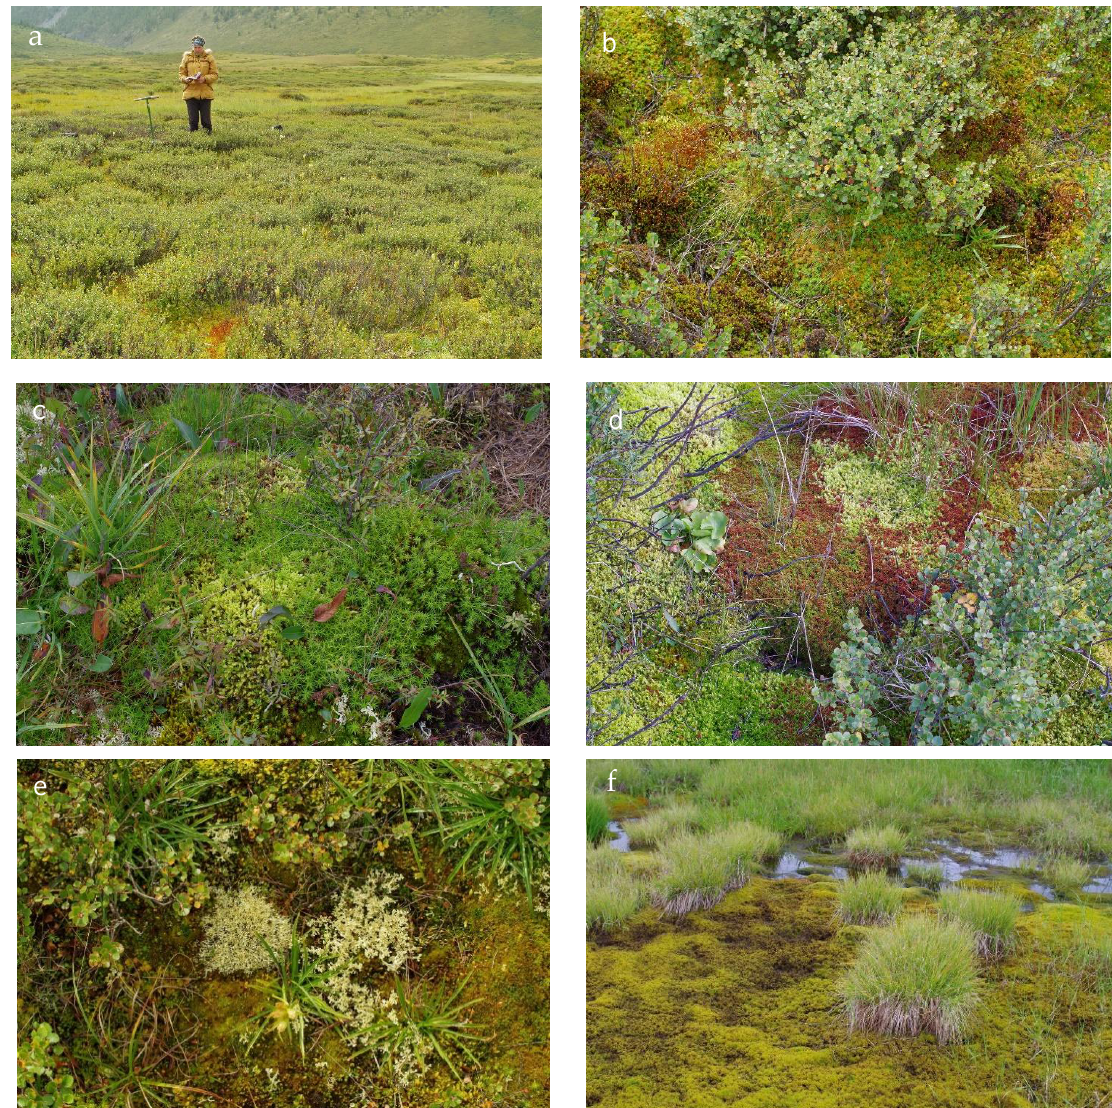
Figure 12. The main types of mires at the Adyr-Khem key site: ( a ) — dwarf shrub-moss mires, ( b ) — small fragment of dwarf shrub-moss mire dominated by Sphagnum mosses, ( c ) — on top of a hillock on shrub-moss mire dominated by green mosses, ( d ) — complex moss cover in dwarf shrub- Sphag- num mire, ( e ) — micro-subsidence on the surface of hillock with lichens, ( f ) — fen with sod tussocks ( Deschampsia cespitosa ) and green mosses (photos by Volkov, 5 August 2021). Dwarf birch- Sphagnum ridges with a sparse and low cover of cloudberries ( Rubus chamaemorus ) (Figure 13-a) occupy small area plots on the periphery of the Adyr-Khem key site. They are formed by a continuous carpet of Sphagnum russowii and S. angustifolium , with sporadically distributed curtains (diameter of 30 – 40 cm) made by Polytrichum strictum, and with small patterns of Arcto-Alpine moss species Dicranum angustum . The expansion of lichens has already begun on the spots of Polytrichum .